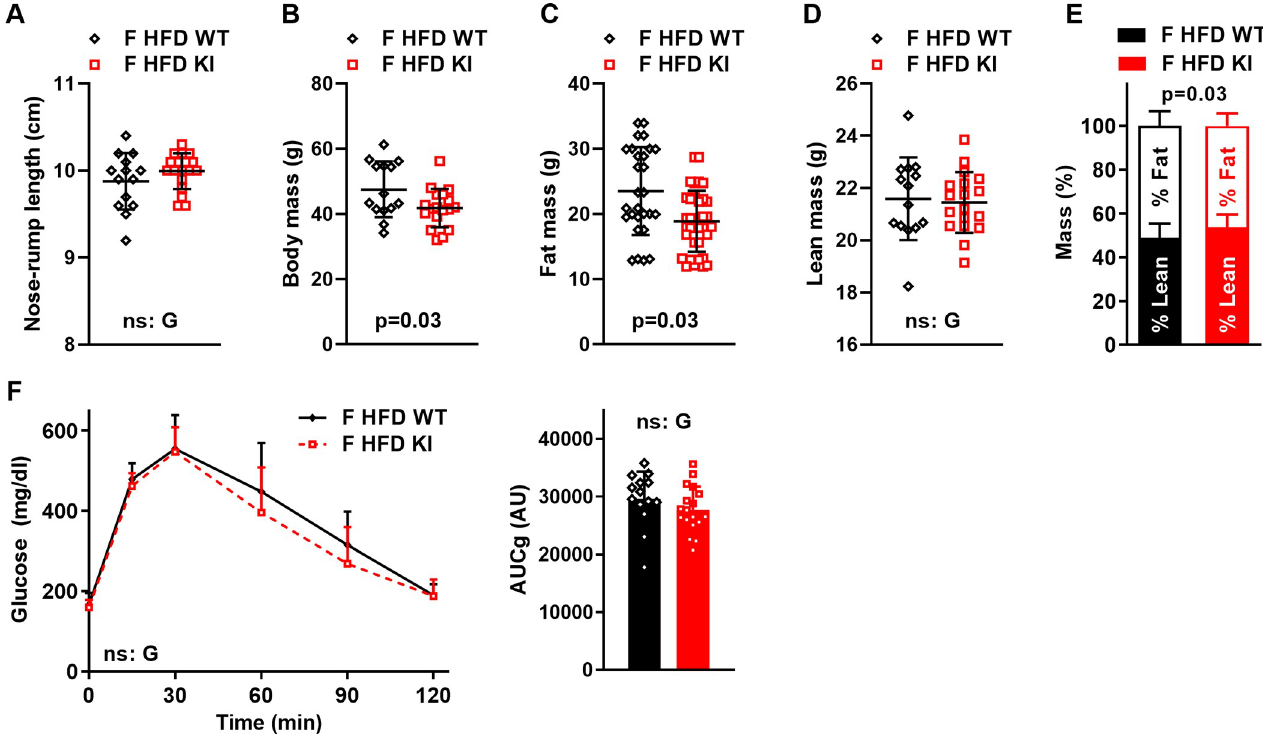
Fig 7. Effect of the CREBRF R458Q variant energy or metabolic homeostasis in response to aging (52 weeks) in mice. Female (F, 52-week-old, HFD-fed, n = 14-18/group) wild-type (WT) and knockin (KI) mice were aged 52 weeks (i.e. 1 year). (A) Nose-rump length (cm), (B) total body mass, (C) fat mas, and (D) lean mass were determined as for younger mice. (E) Fat and lean mass expressed as percent of total body mass. (F) Glucose tolerance tests (GTTs, left) and area under the curve for glucose (AUCg, right). GTT data were analyzed by general linear models with time as a within subject variable and G = genotype (WT, KI) as the fixed factor. All other data were analyzed by unpaired two-tailed t-test. Data are mean (SD). Main effects with a significance level of � 0.05 are labeled as non-significant (ns). Otherwise, p values are indicated.